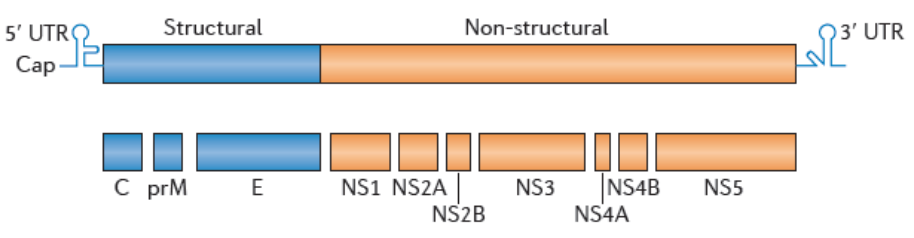
Figure 3. Organisation of the flavivirus